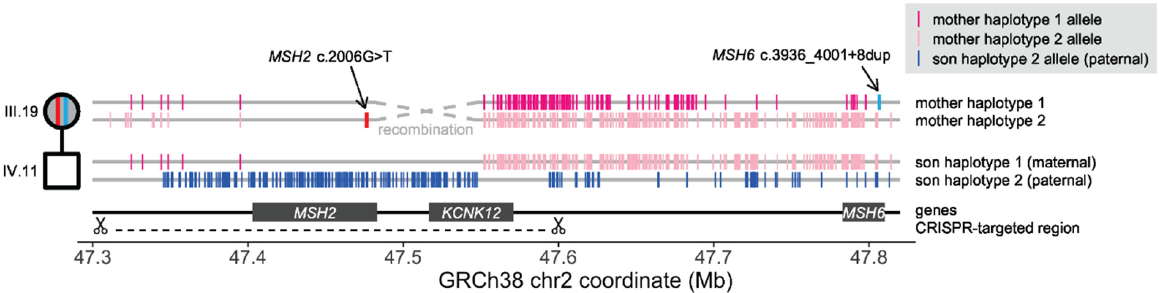
Figure 7. Haplotype reconstruction across Chr2p21-p16 in a mother who carried both trans variants MSH2 c.2006G>T and MSH6 c.3936_4001+8dup (intronic) shows a recombination event between the two maternal alleles had occurred between the locations of the variants. Haplotypes reconstructed from linked-read whole genome sequence and targeted linked-read sequence data are represented by different shades of pink for maternal haplotypes in female family member, III.19, who is a carrier of both MSH2 c.2006G>T (red line) and MSH6 c.3936_4001+8dup (intronic) (teal line) and blue for paternal haplotypes in her eldest son, IV.11, who did not inherit either variant. The locations of the informative polymorphisms used to reconstruct haplotypes are indicated by the pink (maternal genotypes) and blue (paternal genotypes) lines. The location of the recombination between the two maternal haplotypes is indicated by a dashed gray line.